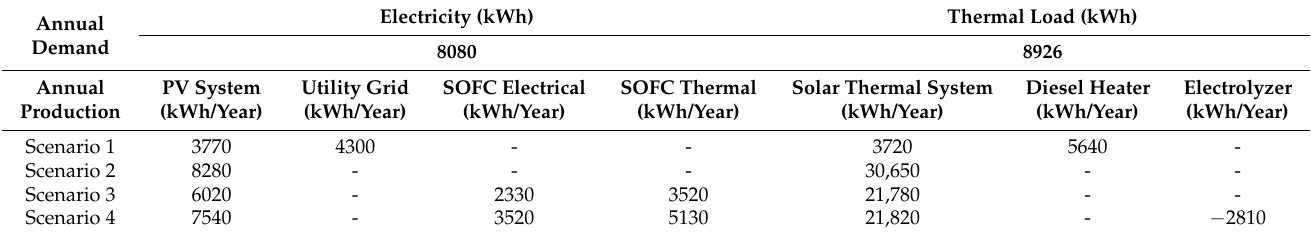
Table 8. Annual energy demands and simulated annual energy productions of the PV, the SOFC system, the utility grid, the solar thermal system, the diesel heater and the electrolyzer for the different simulation scenarios.